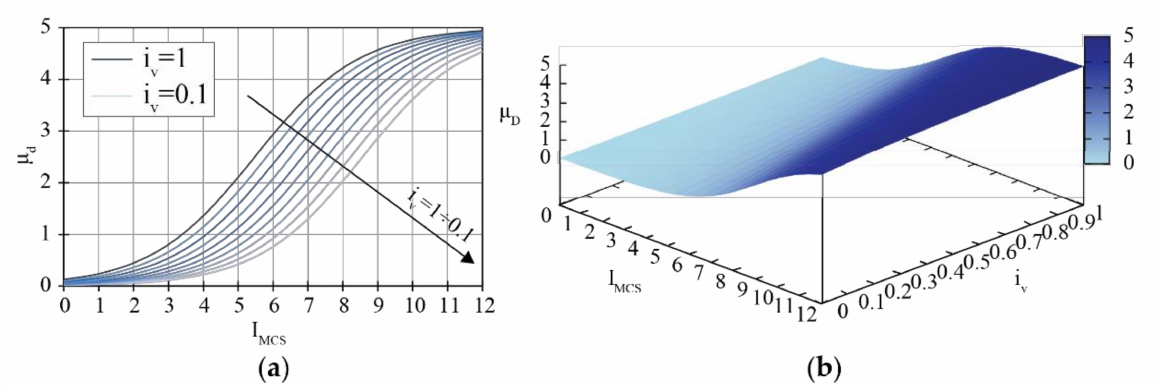
Figure 3. Vulnerability function in ( a ) I MCS - µ D plane and ( b ) I MCS - µ D -i v